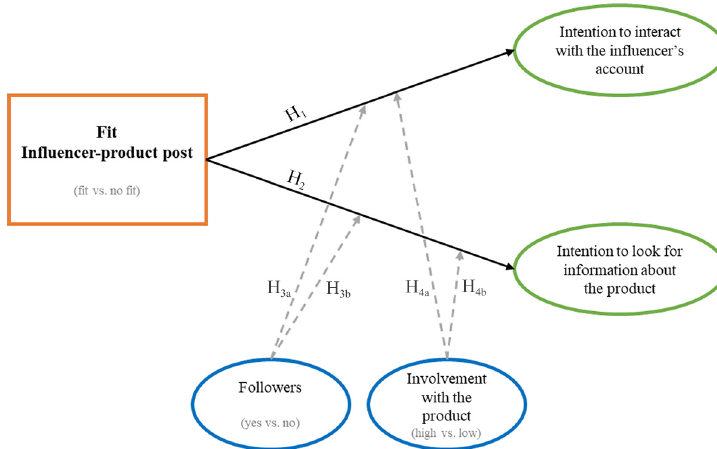
Figure 1. Research model and proposed